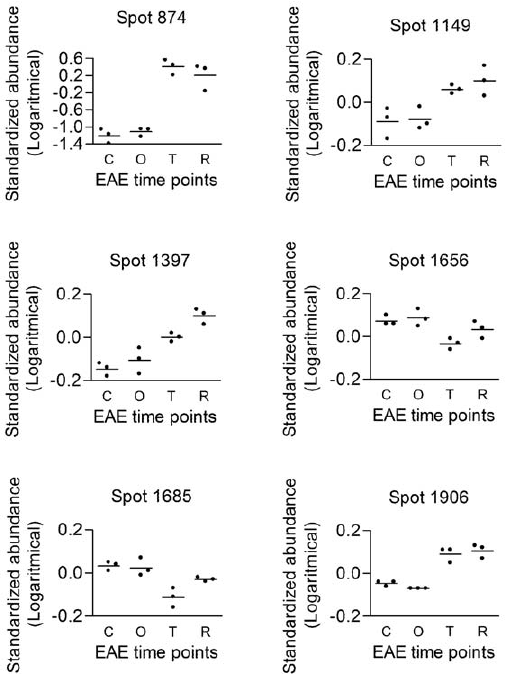
Figure 4. Protein expression patterns over the disease course. 2D-DIGE expression profiles: ALB (spot 874), PDIA3 (spot 1149), GFAP (spot 1397), CNP (spot 1656 and 1685) and CAPG (spot 1906). The log standard abundance (the relative abundance change normalized to signals in internal standard specific for each spot) is indicated for control, onset, top and recovery